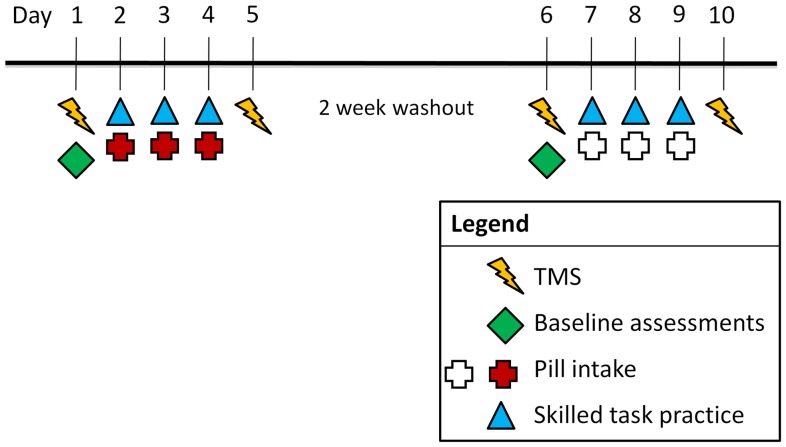
The experimental protocol.